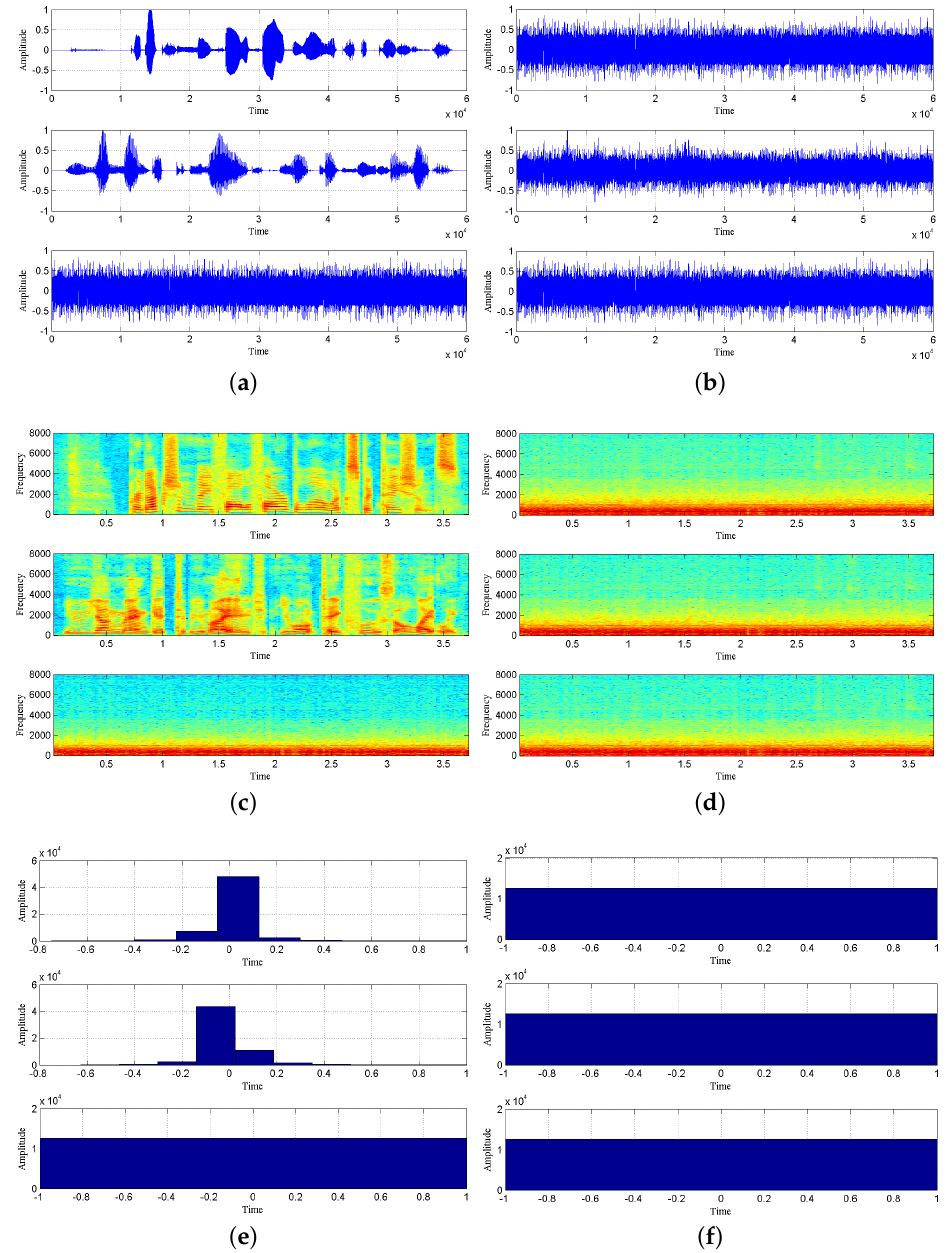
Figure 4. The graphical information of the source and observed signals. ( a ) Time-domain waveform of the source signals; ( b ) Time-domain waveform of the observed signal. ( c ) Spectrogram of the source signal; ( d ) Spectrogram of the observed signal; ( e ) Histogram of the source signal; ( f ) Histogram of the observed